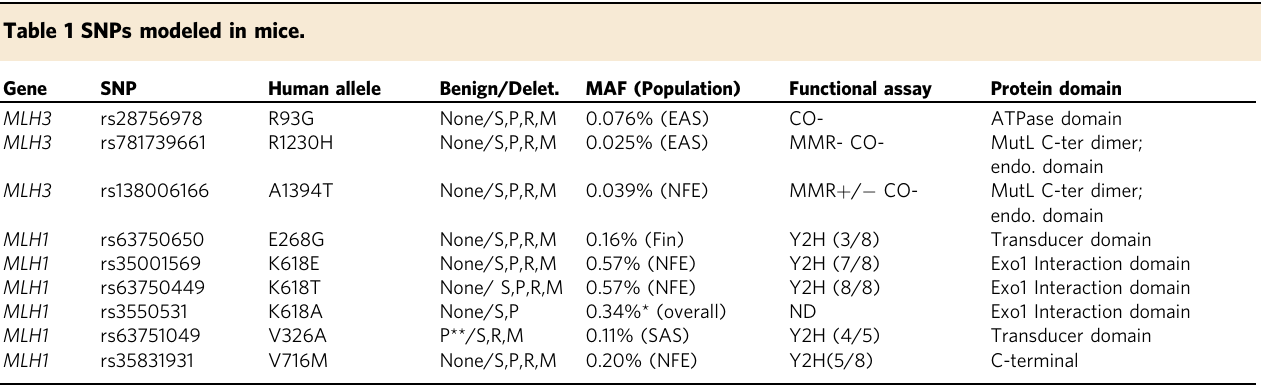
gnomAD (http://gnomad.broadinstitute.org) allele frequencies (version 2.1.1) correspond to the population with the highest allele frequency (AF). EAS East Asian, NFE European (non-Finnish), Fin Finnish, SAS South Asian, S SIFT, P Polyphen2, REVEL R, M Mutation assessor, ND no data, MMR mismatch repair, CO meiotic crossing over phenotypes ( + , wildtype, − , null), dimer dimerization, endo endonuclease, “ Y2H ” yeast two-hybrid disruption, with the values in parentheses indicating the fraction of known interactions with proteins disrupted by